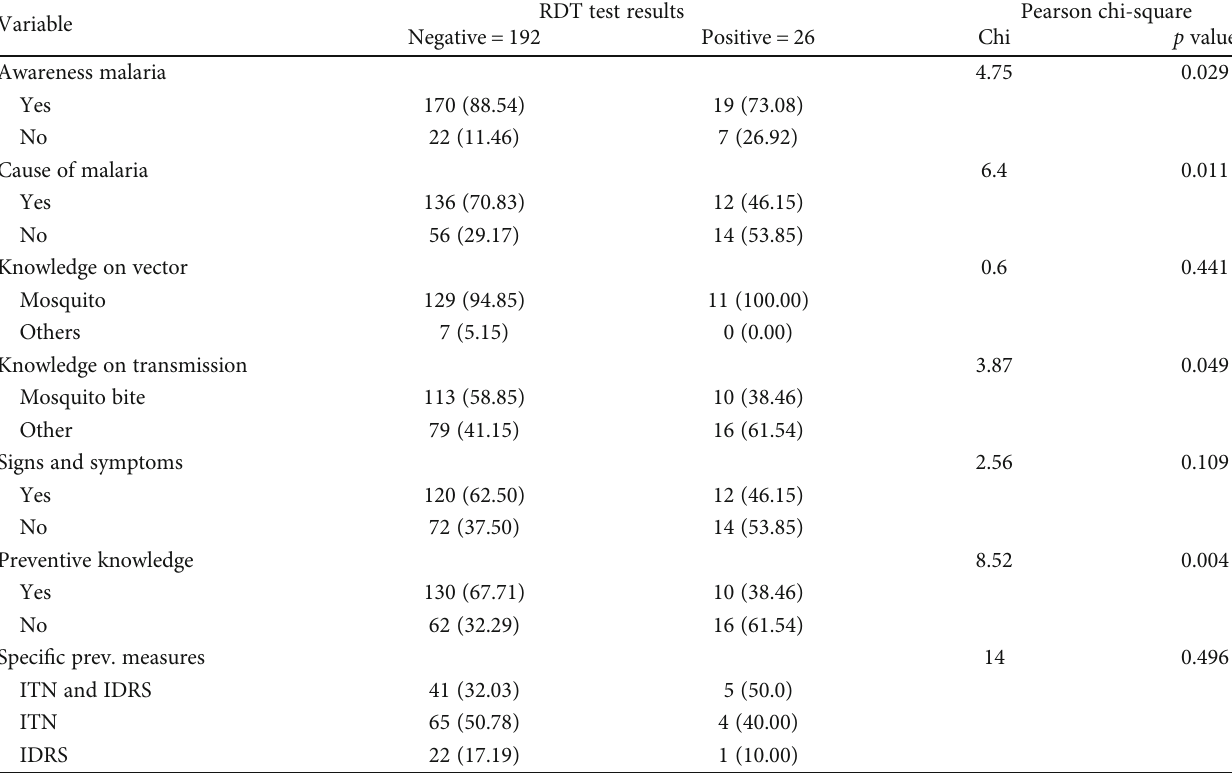
Table 3: Association between study variables of malaria positive test using